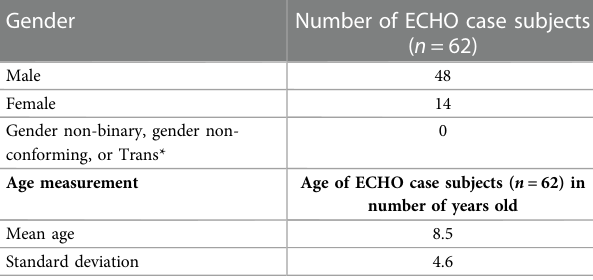
female patients. Case subject ages ranged from 1.4 years to 21 years.